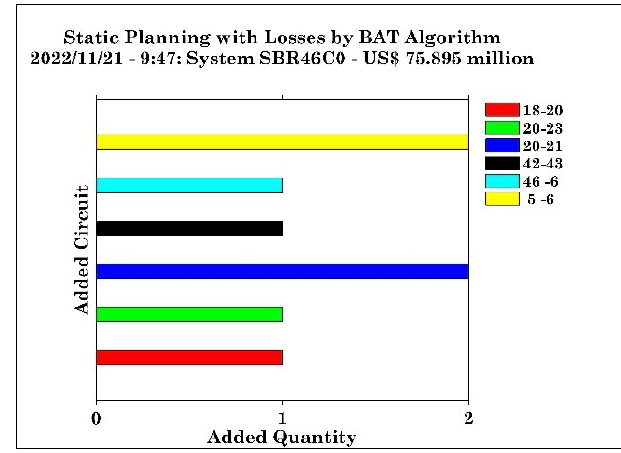
Figure 15: Case WR - SB-46/79 test